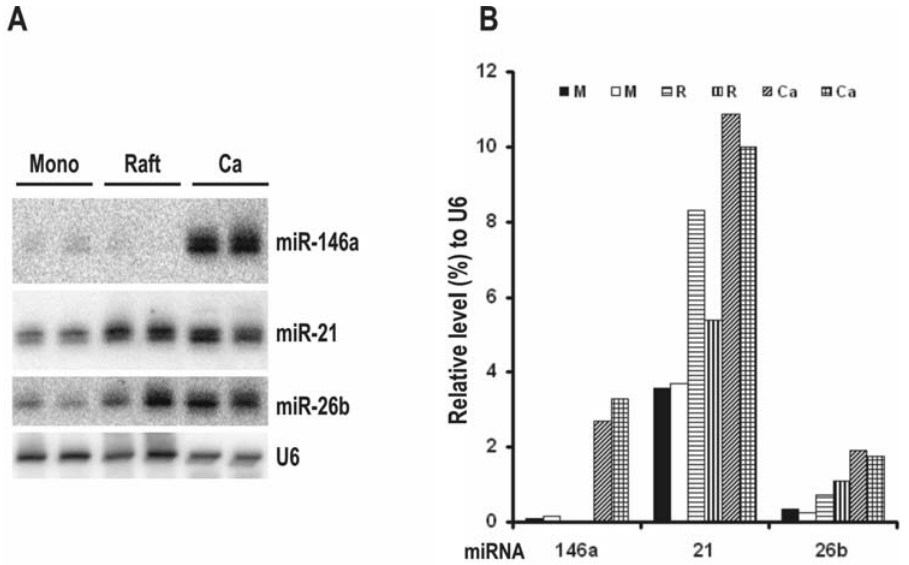
Figure 5. Upregulation of miR-146a is cervical cancer-specific. A . Total RNAs from HVKs in two rafts and two monolayer (Mono) cultures were compared with two cervical cancer (Ca) tissues for the expression of miR-146a by northern blotting. The expression levels of miR-21 and miR-26b were examined as miRNA controls. Small nuclear RNA U6 was also blotted as an internal control for sample loading. B . Bar graphs show the relative levels of the examined miRNAs normalized to U6 RNA in each sample in panel A . M=monolayer culture, R=raft.